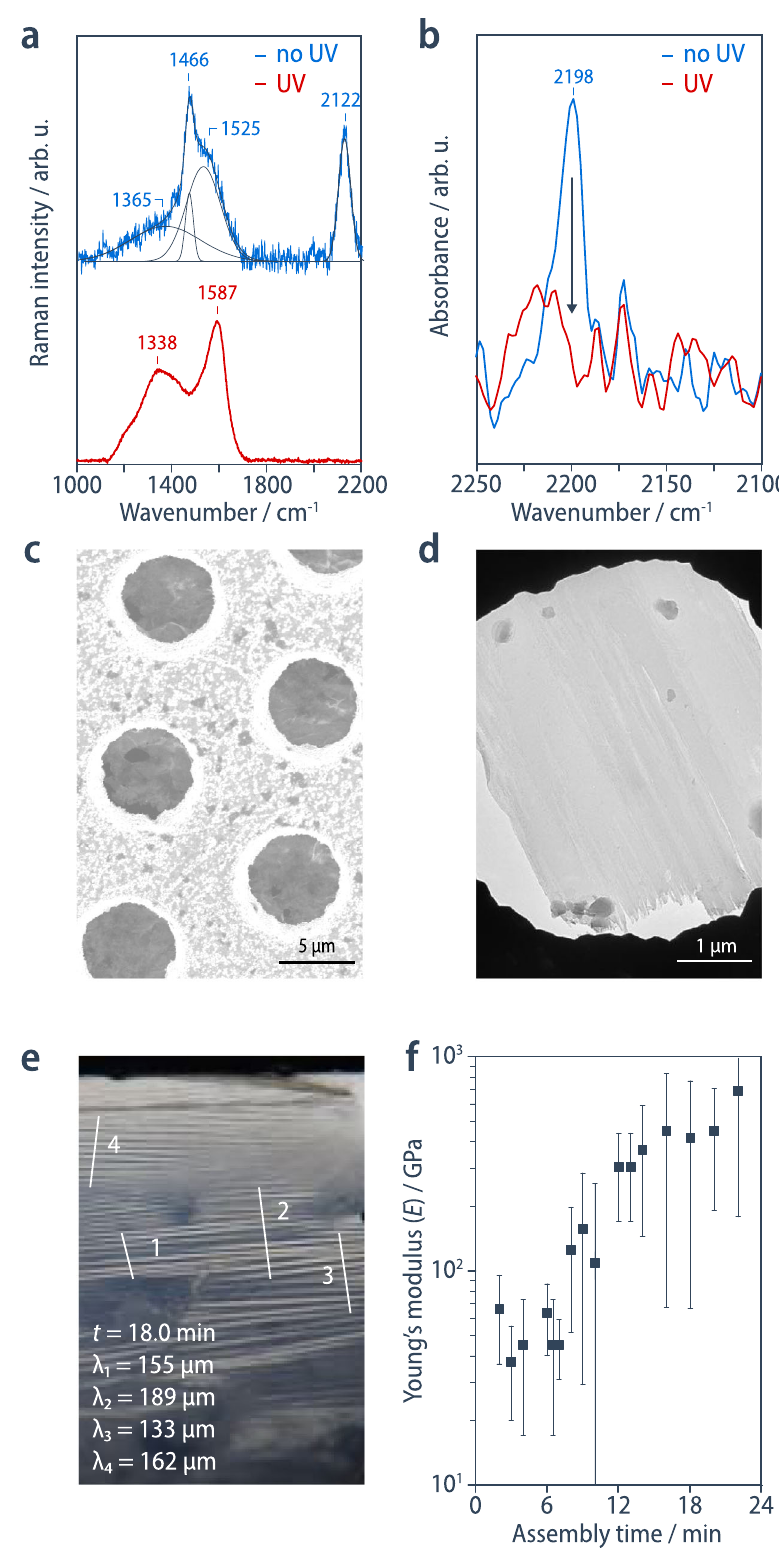
Fig. 3 Structural and mechanical characterization of the carbon nanoskin. a Raman spectra, and b IR re fl ection-absorption spectra of the carbon nanoskin as-formed and after accelerated carbonization using UV irradiation. c Scanning electron micrographs and d transmission electron micrographs (SEM, TEM) of the carbon nanoskin after transfer to a copper mesh substrate show a homogeneous and mechanically self-supporting fi lm over many micrometers. e Photograph of the nanoskin at a fl at chloroform/water interface showing the wrinkling patterns that are formed upon compression and their corresponding wavelength measurement pro fi les. f Conversion of the wavelength to the elastic modulus in bending, considering the thickness determined from the ellipsometry